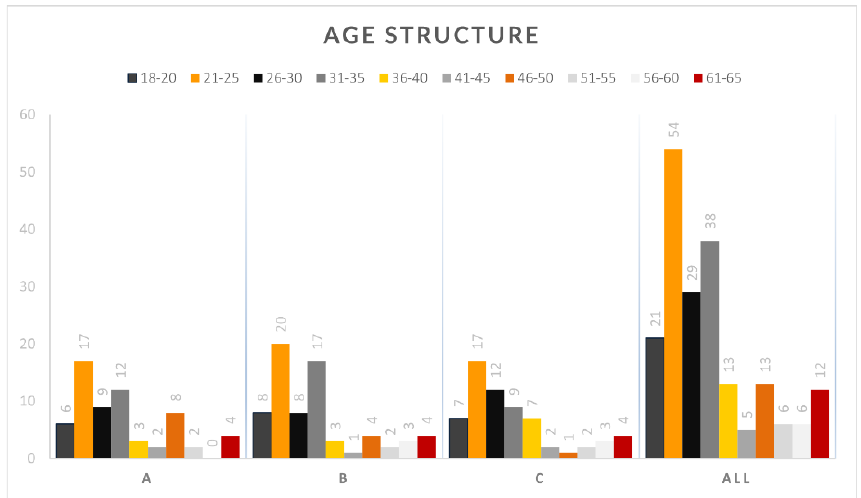
Figure 4. Age structure among participants.